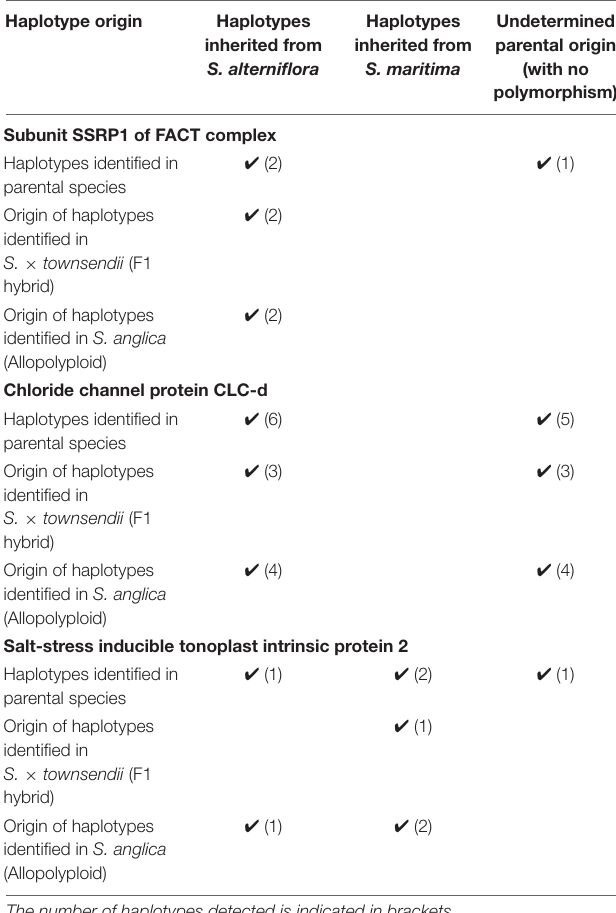
TABLE 5 | Evolution of gene expression patterns between the F1 hybrid S. × townsendii and the allopolyploid S. anglica . Expression pattern in